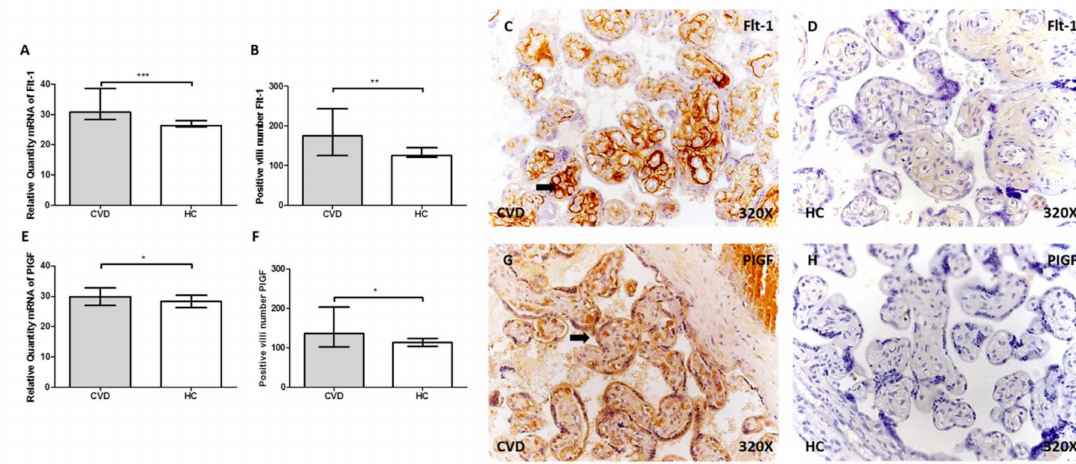
Figure 2. A–B. mRNA expression levels by RT-qPCR and positive vessels number for Flt-1. C–D. Images showing the immunostaining for Flt-1 in the placental villi for CVD ( C ) and HC ( D ) by immunohistochemistry. E–F. mRNA expression levels by RT-qPCR and positive vessels number for placental growth factor (PIGF). G–H. Images showing the immunostaining for PIGF in the placental villi for CVD ( G ) and HC ( H ) by immunohistochemistry. CVD = pregnancy-associated lower extremity chronic venous disease. HC = healthy controls with no history of CVD. p < 0.05 (*), p < 0.01 (**), and p < 0.001 (***). Arrow = positive protein expression.